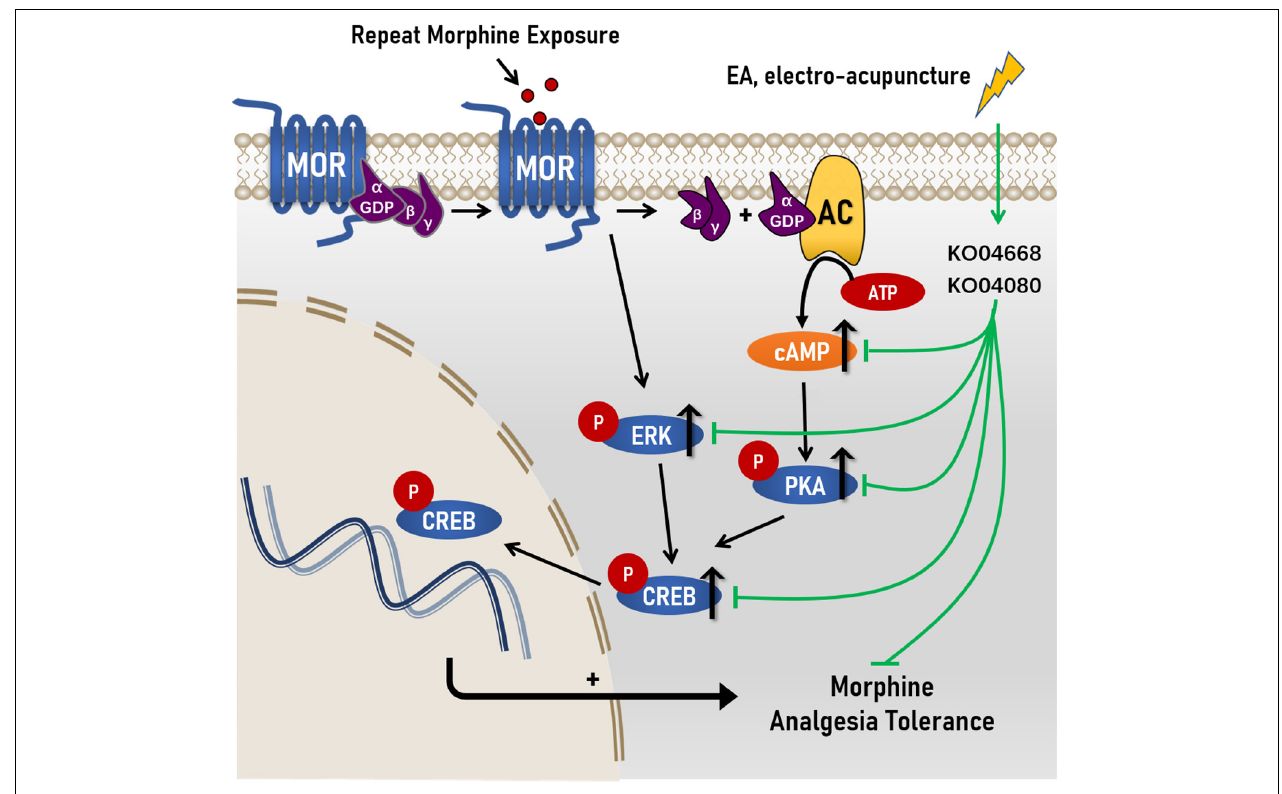
FIGURE 7 | Proposed mechanisms of action by which EA ameliorated morphine-induced tolerance in mice. Chronic morphine increased the levels of cAMP, and the levels of phosphorylation levels of protein kinase A (PKA), extracellular regulated protein kinases (ERK) and cAMP response element-binding (CREB) in morphine-induced tolerance. After the treatment of Electro-Acupuncture, the increased of cAMP, p-PKA C, p-ERK, and p-CREB were significantly decreased in morphine-induce tolerance. Simultaneously, RNA sequencing reval the underlying molecular targets of EA treatment on morphine-induced tolerance maybe KO04080 (Neuroactive ligand-receptor interaction) and KO04668 (TNF signaling